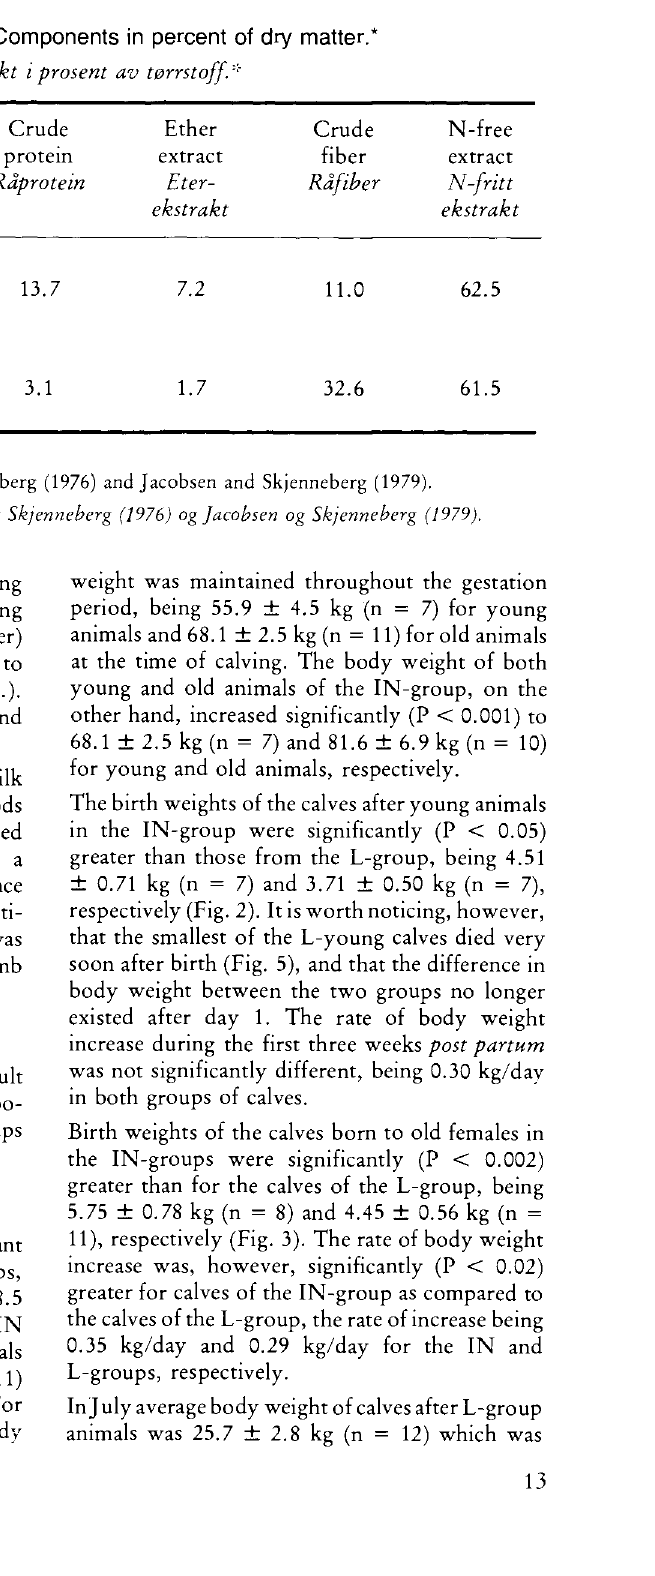
Table 2. Chemical composition of the diets. Components in percent of dry